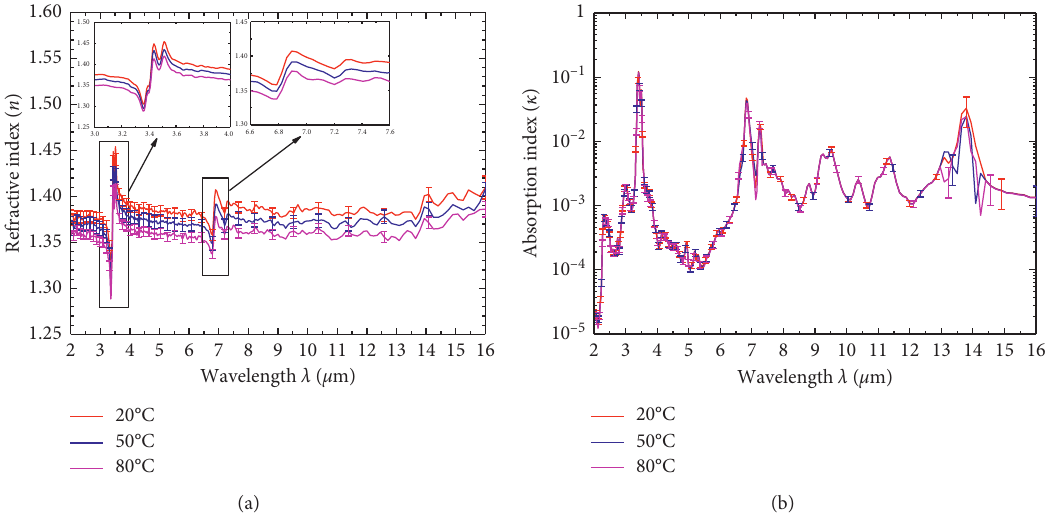
Figure 2: Refractive index n and absorption index κ of liquid n-octane at 20, 50 ° C, and 80 ° C.